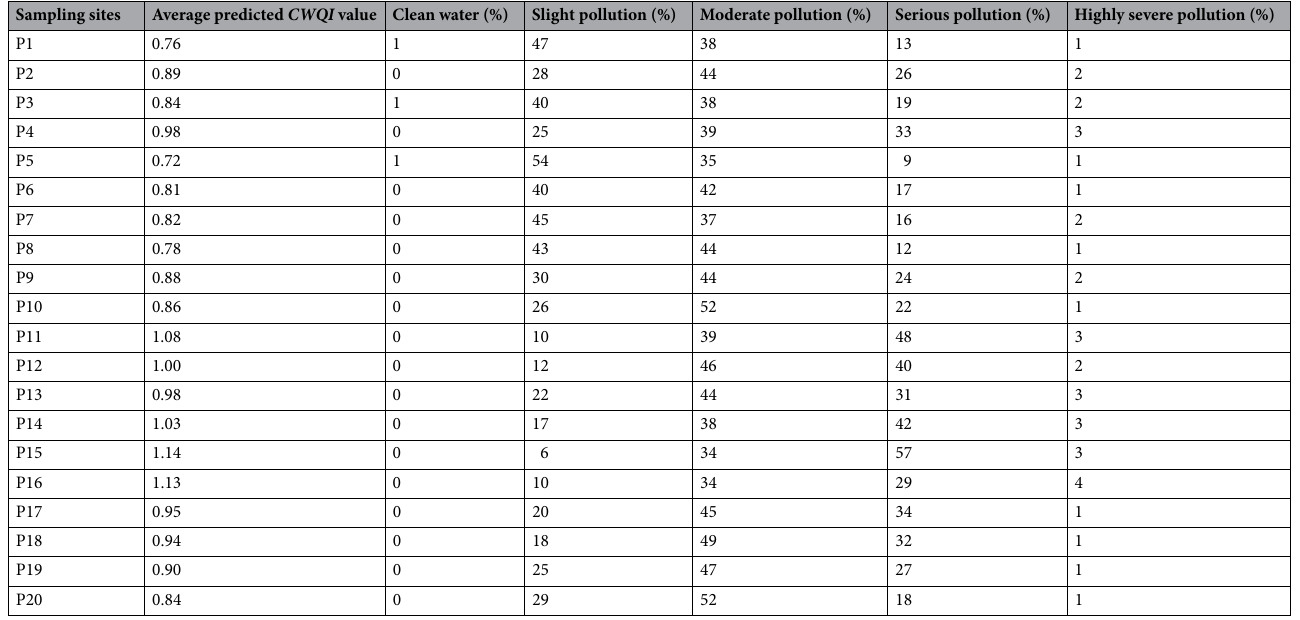
Table 2. Probability distributions of the CWQI for the different sampling locations in the East Tiaoxi